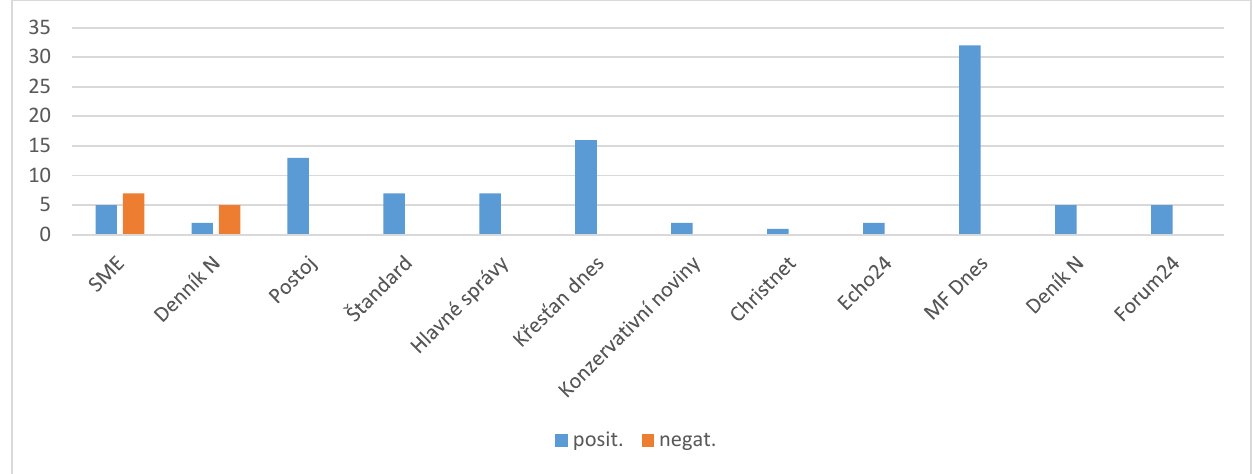
Figure 4. Occurrences of the ‘importance of faith’ as an argument (A3).